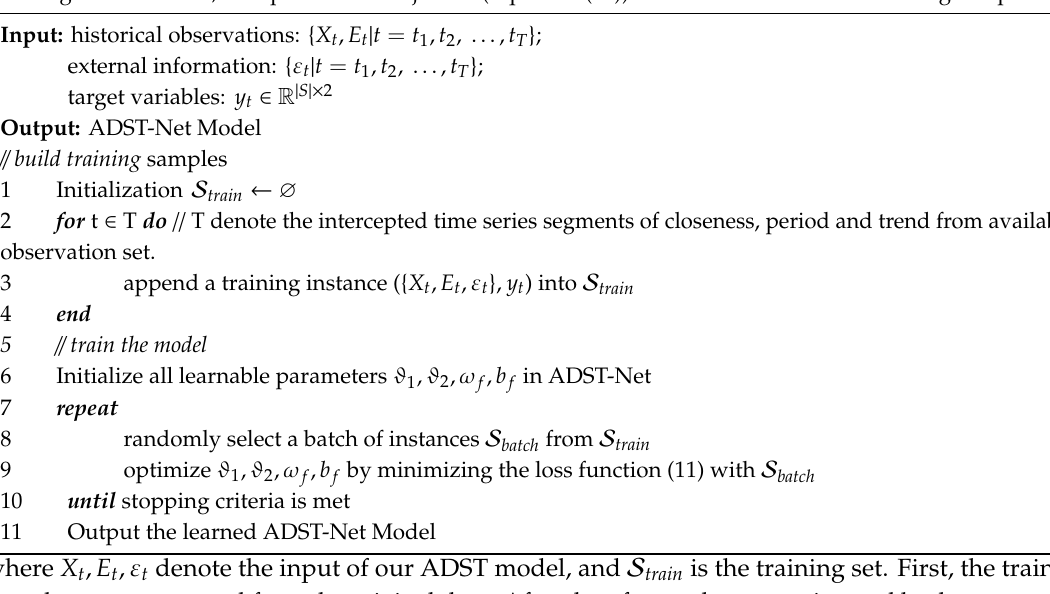
Algorithm 1. Training Pipeline of ADST-Net Algorithm. The training pseudo code of the ADST-Net algorithm. During each iteration, we optimize the objective (Equation (11)) on the selected batch of training